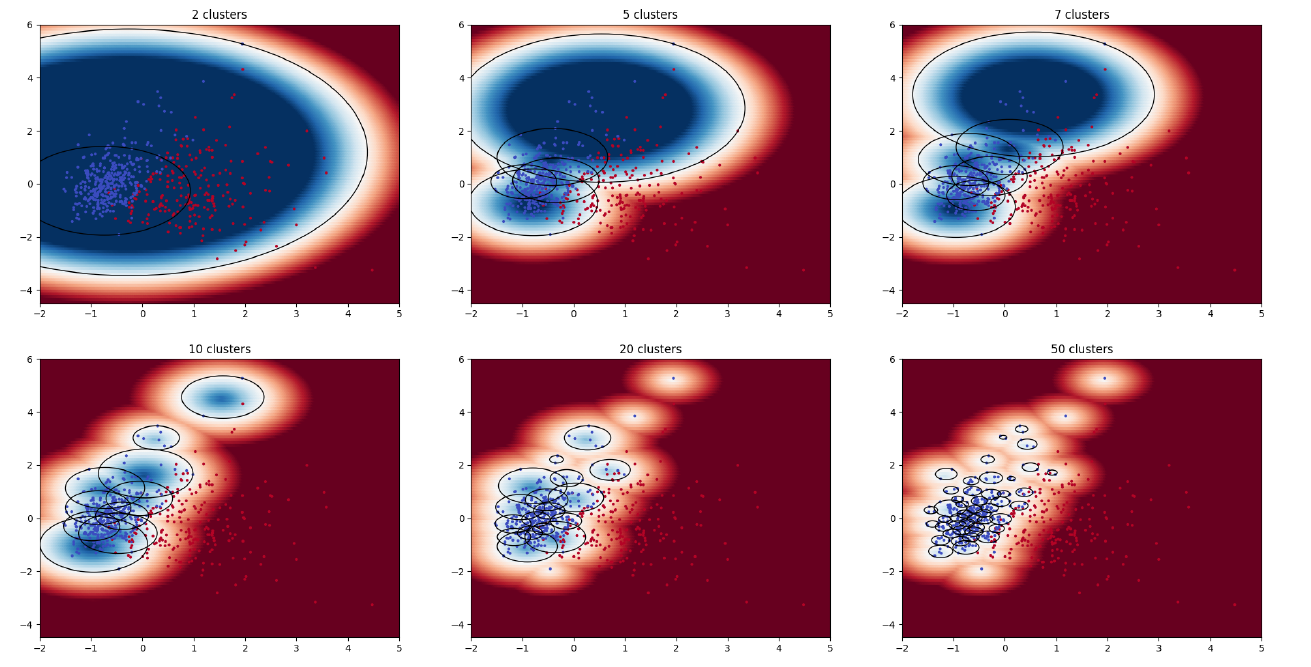
Figure 9. Heat map of K-Means for different numbers of clusters on the same